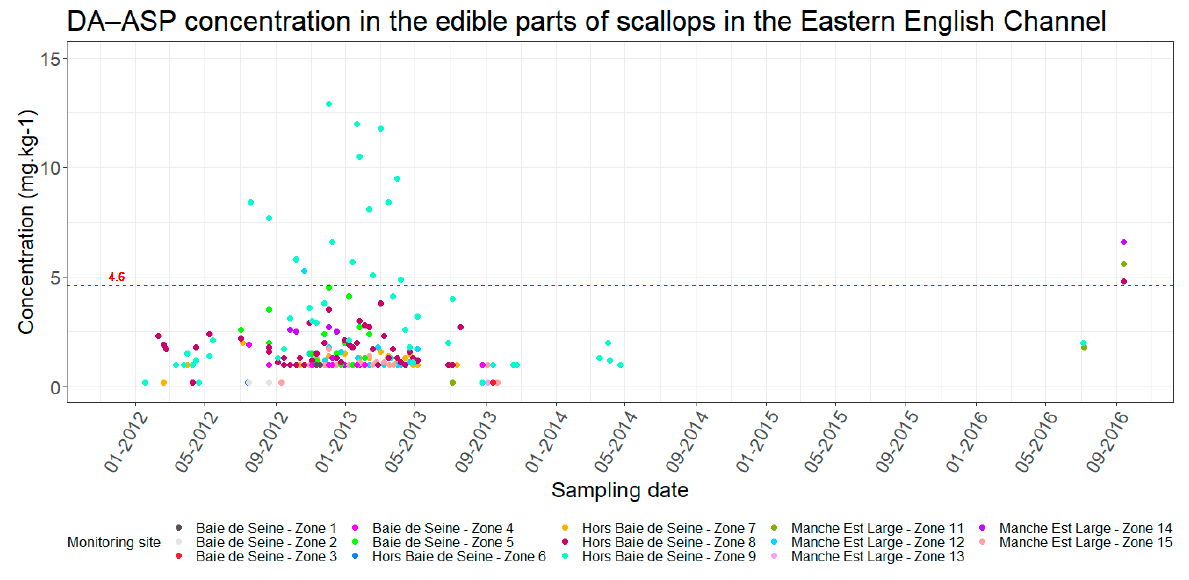
Figure 6. Evolution of ASP concentrations in edible parts of scallops in the eastern Channel. Red dotted line = regulatory toxicity threshold.